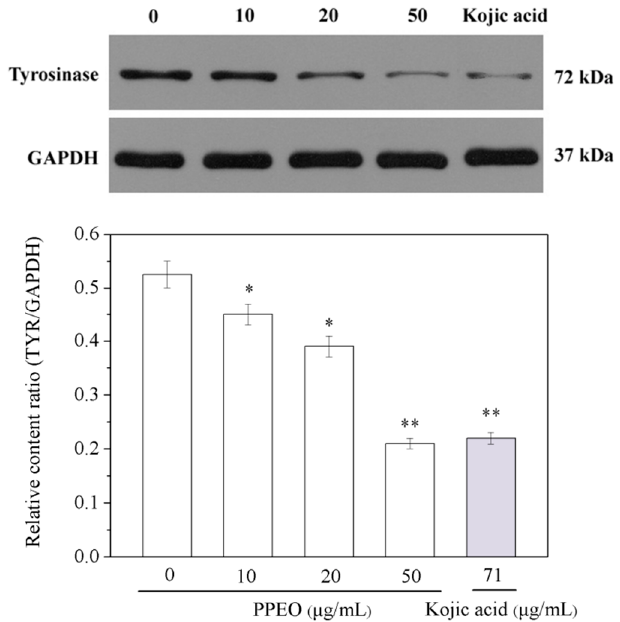
Figure 6. Effect of PPEO on tyrosinase expression in B16 cells. * Indicates samples that are significantly different ( n = 3; * p < 0.05 and ** p < 0.01 compared with the blank control group). GADPH: glyceraldehyde-3-phosphate dehydrogenase.